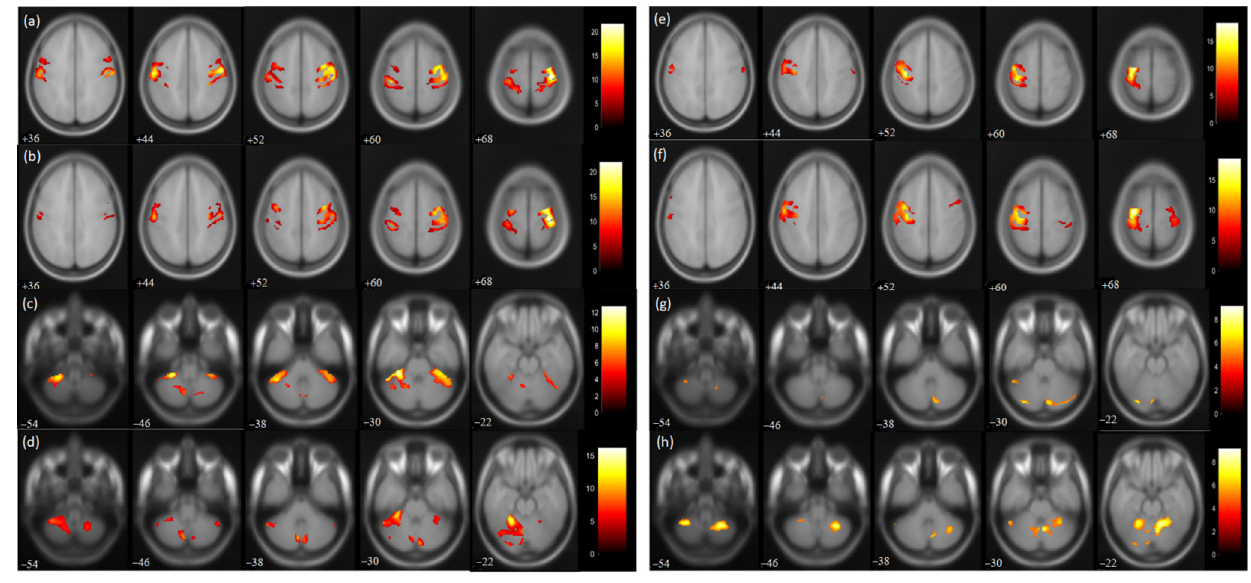
Figure 3. BOLD functional MR images for wrist extension task with voxel level threshold p < 0.05 (FWE corrected) and cluster level threshold of 5 voxels. Talairach-client was used to correlate MNI coordinates with gray and white matter. ( a , c ) pre-therapy activations and ( b , d ) post-therapy activations during affected hand trial; ( e , g ) pre-therapy activations and ( f , h ) post-therapy activations during unaffected hand trial for the masked regions of sensorimotor cortex (36:8:68 slices) and cerebellum (−54:8:−22 slices). Table 2. Pre- and Post-VR Blood Oxygen Level Dependent (BOLD) activation pattern in affected and unaffected hand trials in masked regions of patient ‘P’. P: Task by Affected